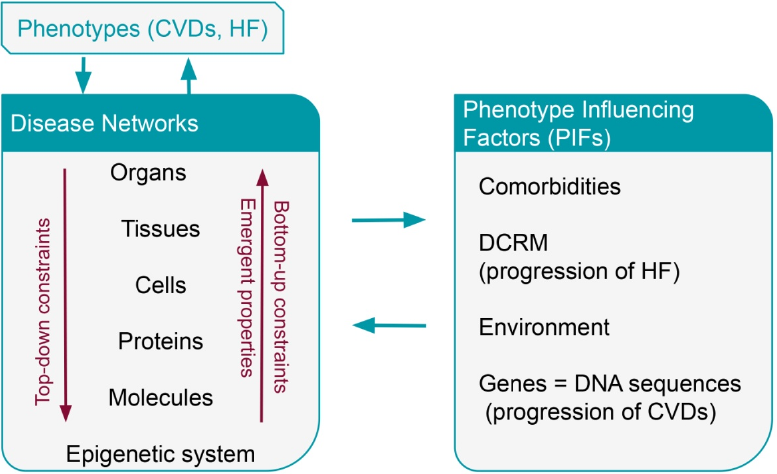
Figure 3. Interaction between phenotypes, disease networks and Phenotype Influencing Factors (PIFs) in CVDs and HF. CVDs = cardiovascular diseases; HF = heart failure; PIFs = Phenotype Influencing Factors (PIFs); DCRM = disease compensatory regulatory mechanisms; deoxyribonucleic acid (DNA).